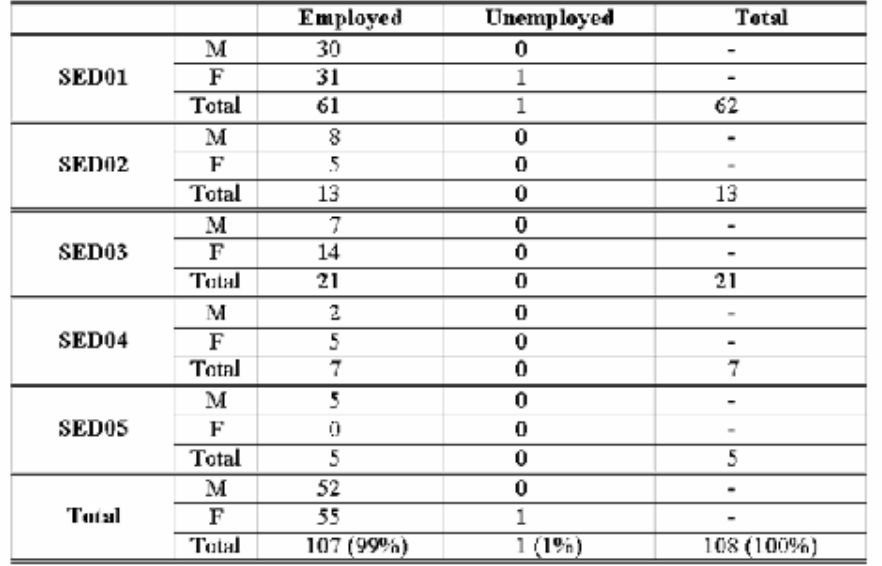
As Table 3 makes evident, all students who dropped out (with the exception of one) were employed. Only one student enrolled in module SED01 (Open and Distance Learning Education) was unemployed. Table 3. Employment status of students who dropped out ( m = male, f = female)